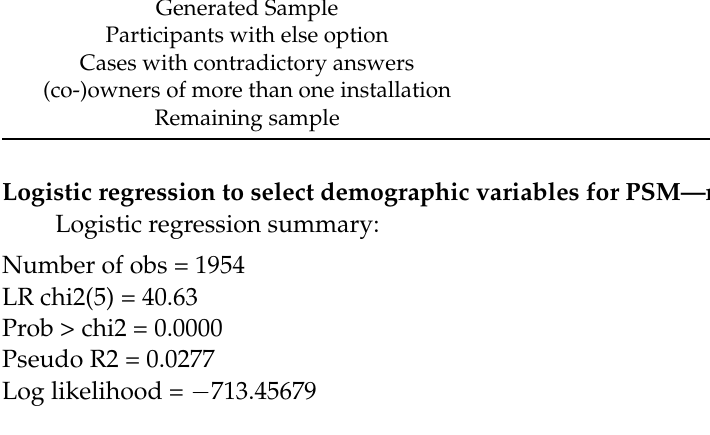
Table A4. Logistic regression to determine matching variables (source: authors’ own calculations). Participation